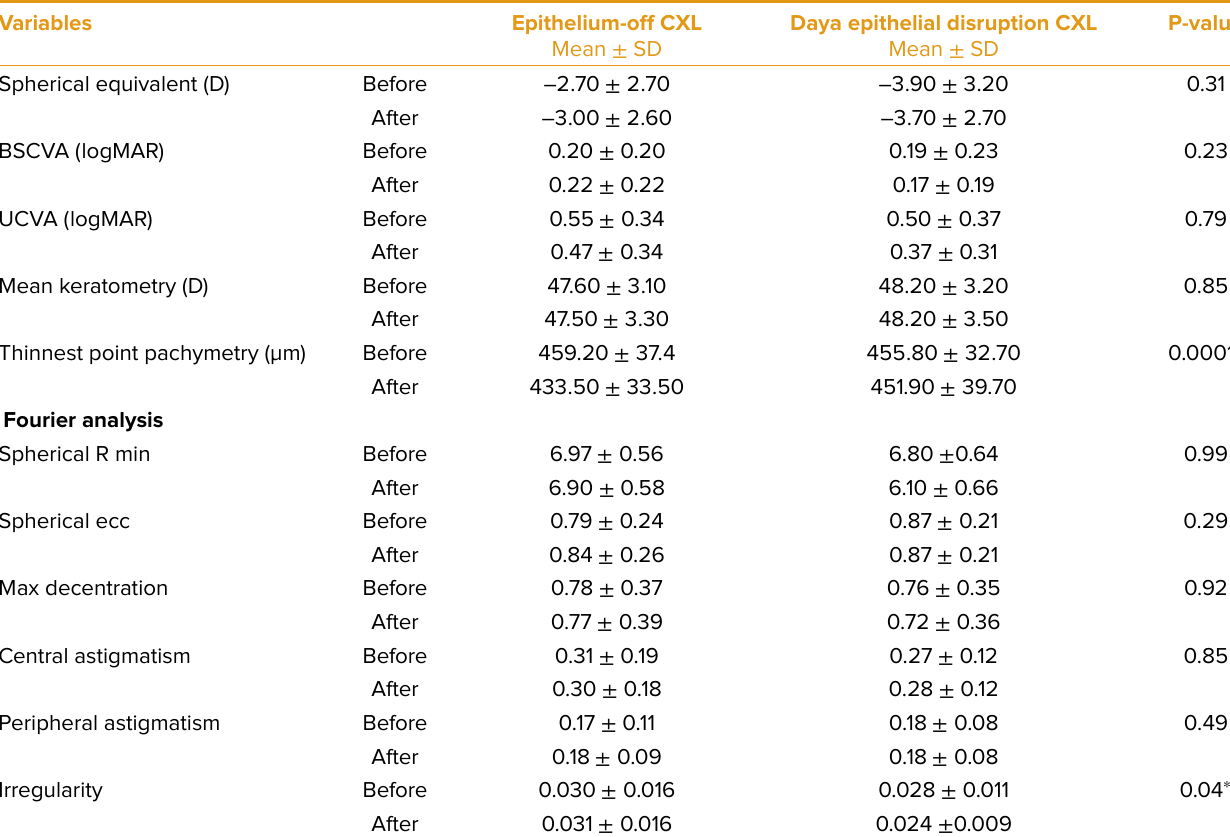
Table 2. Clinical outcomes of epithelium removal CXL and epithelial-disruption CXL after a mean follow-up of six